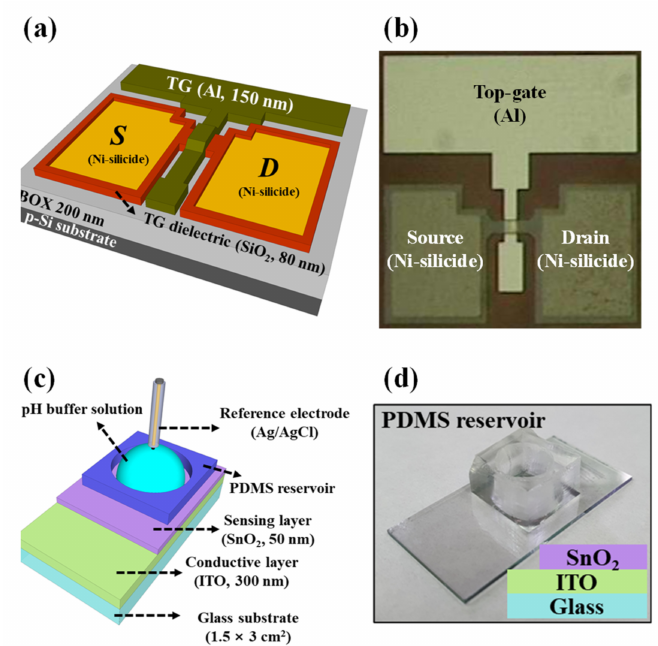
Figure 1. ( a ) Schematic and ( b ) microscopic image of ambipolar DG ISFET with Ni-silicide SB S/Ds on an SOI substrate. ( c ) Schematic and ( d ) photograph of the fabricated EG